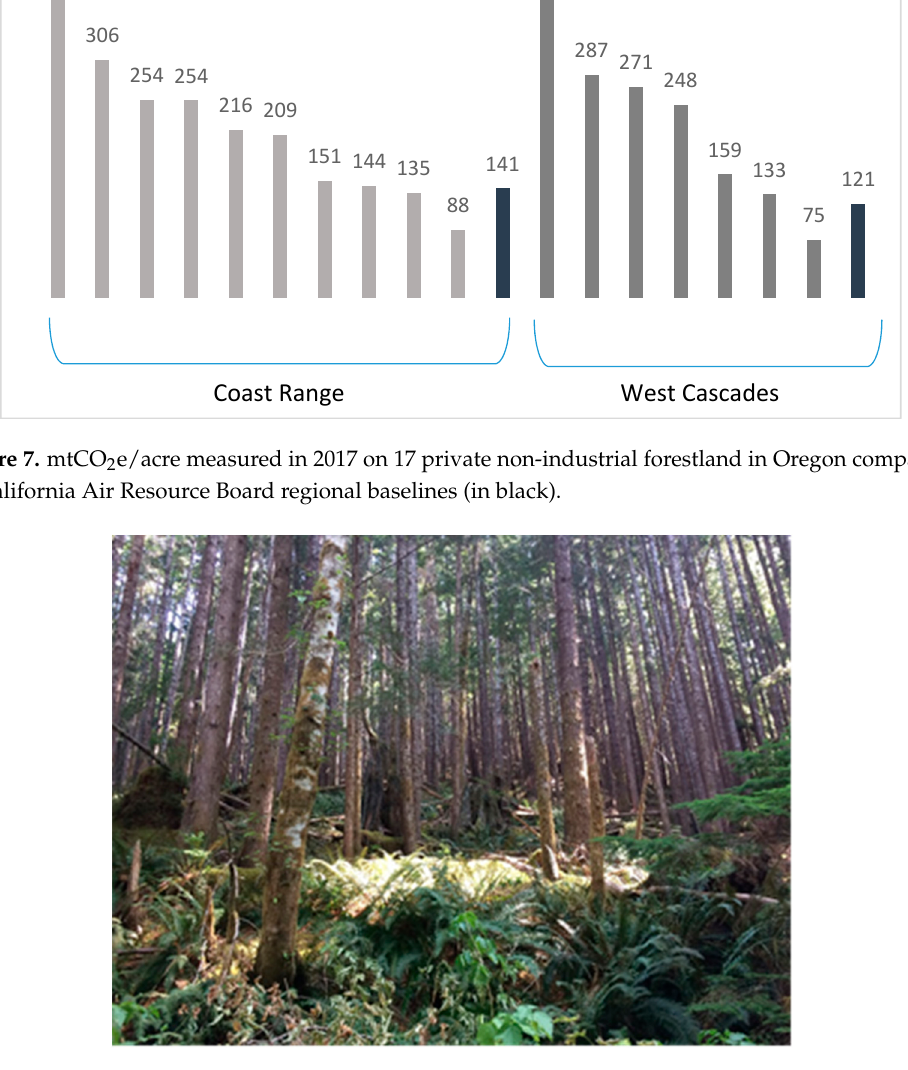
Figure 8. A 35–40 year old, densely stocked Douglas Fir stand in the Western Cascades. This stand stores an average of 120 mtCO 2 e/acre.